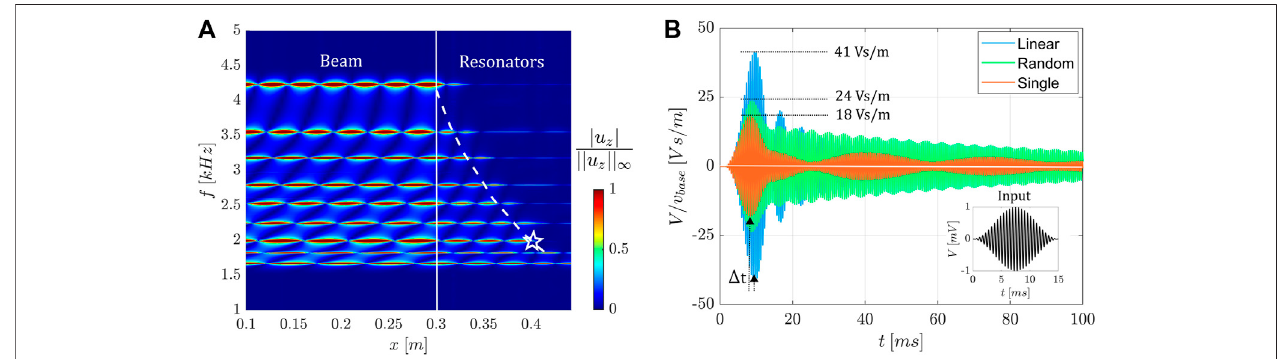
FIGURE 6 | (A) Space-frequency analysis of the experimental data superimposed to numerical predictions (dashed white line) from dispersion curves. (B) Open circuit output voltage for the linear, random and single cell con fi guration, corresponding to the input excitation frequency marked with the white star in (A) . The linear grading provides the maximum output voltage and time